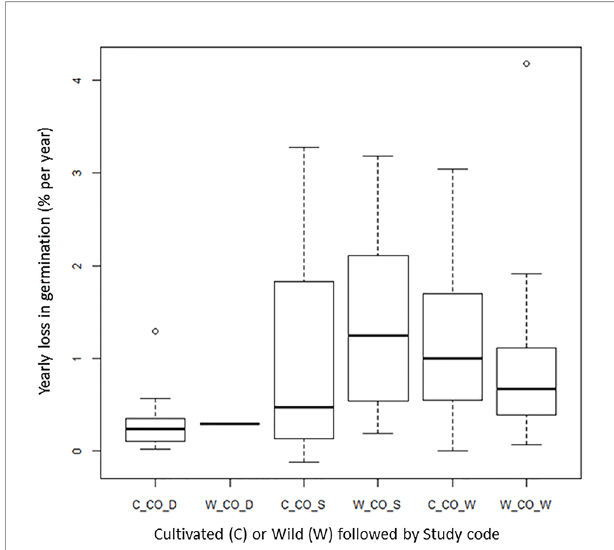
FIGURE 5 | Average yearly decline in germination (DeltaG_Y) for cultivated (pre fi x C-) and wild (pre fi x W-) material in the given long-term studies under cold storage: Desheva (2016): CO_D; Stanwood (see Walters et al., 2005): CO_S, Walters et al. (2005): CO_W; Roos and Davidson (1992):